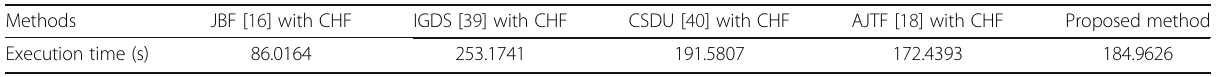
Table 6 Execution time of related methods and proposed method Methods